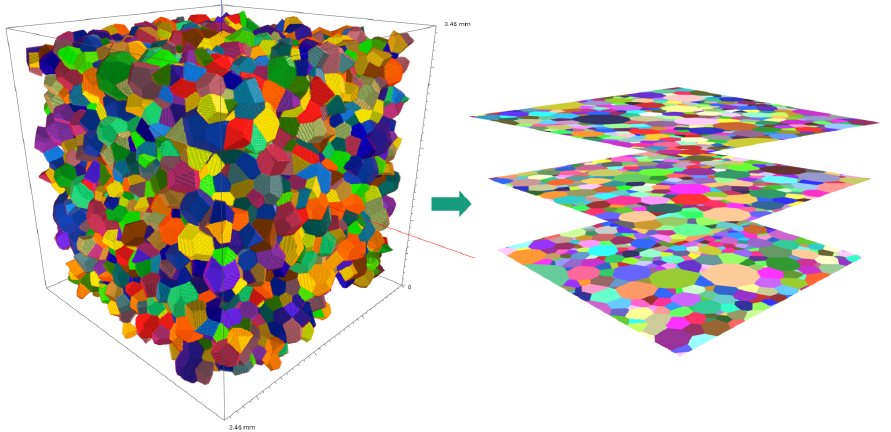
Figure 9. Visualization of the model fit for the Inconel-617. Left : Rendering of a realization of the random Laguerre tessellation with overall 2000 cells in a cube of edge length 3.91 mm, and volume 60mm 3 . Right : 2D sections compared with the micrographs. The cells are visualized by false color